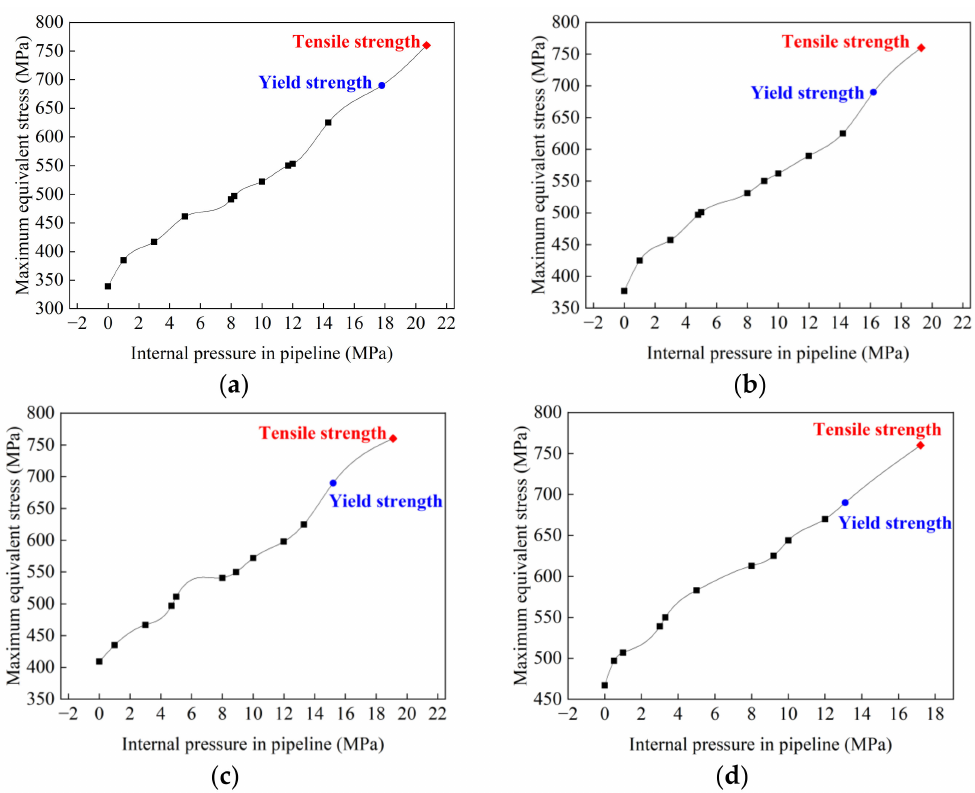
Figure 15. Relationship between joint equivalent stress and internal pressure with butt gap of: